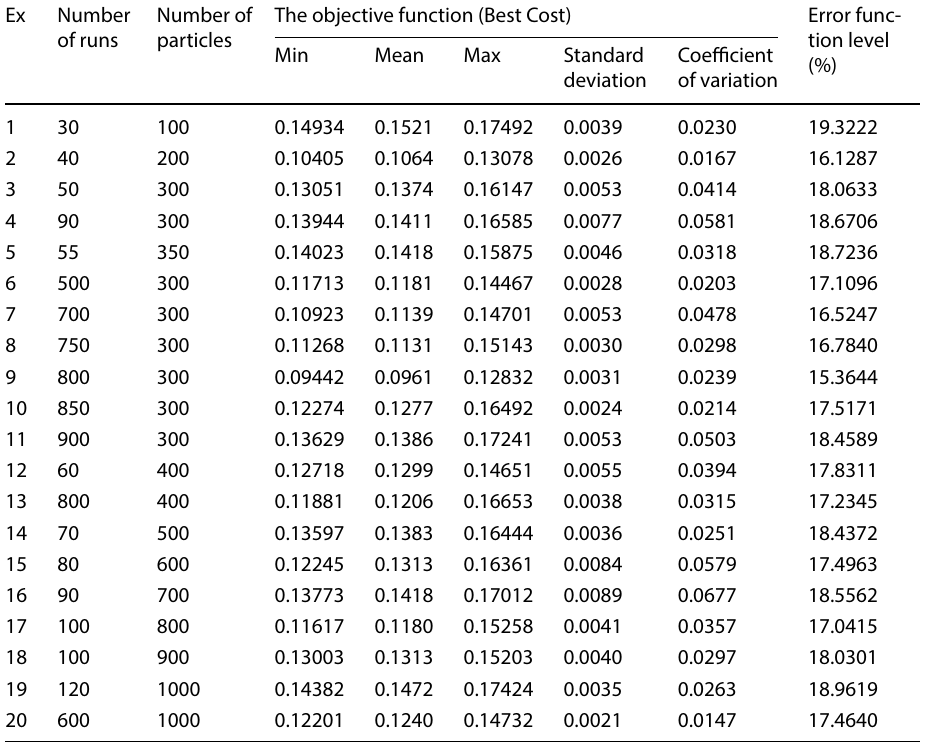
Table 5 Objective function levels for different program executions in the ANN by the PSO optimizer function